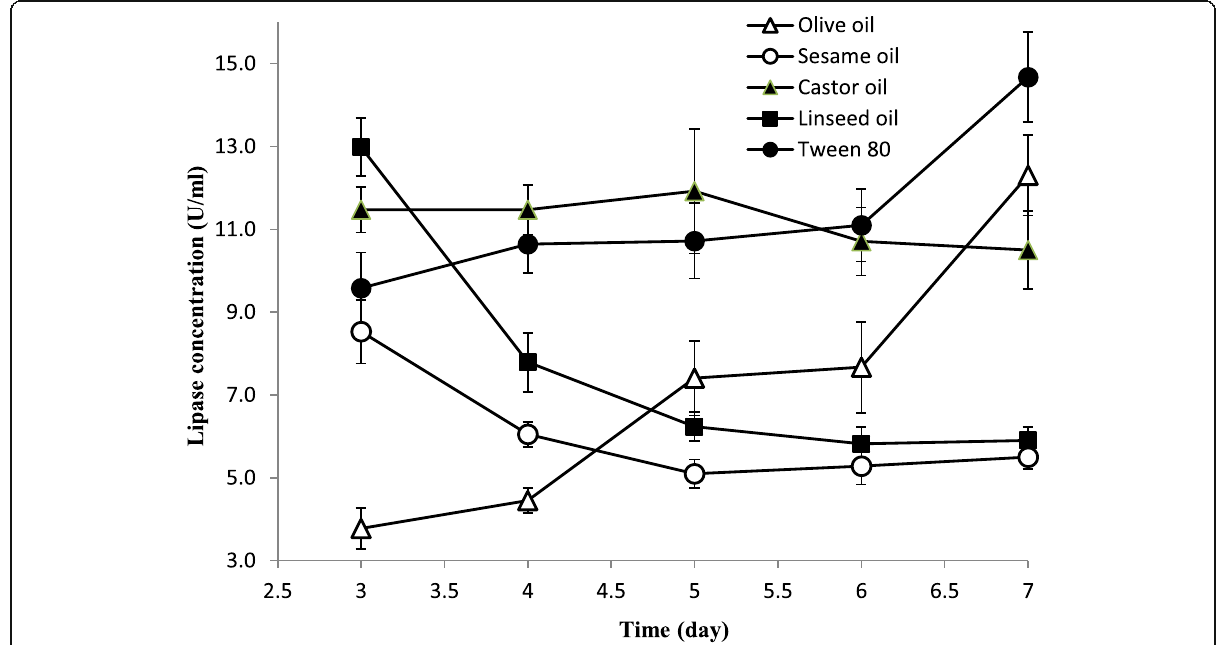
Fig. 4 Induction of lipase production by different substrates. Bars in the figure represent the standard error between replicates